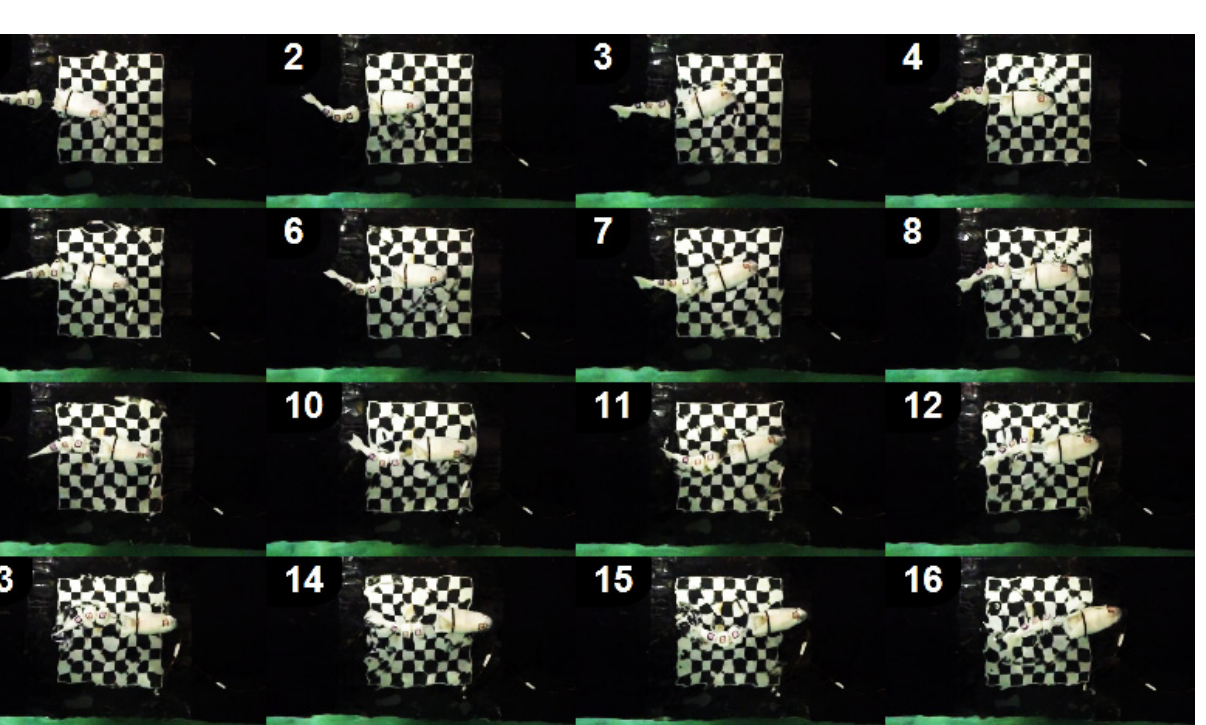
Table 5. Frequency data and relative swimming speed values.